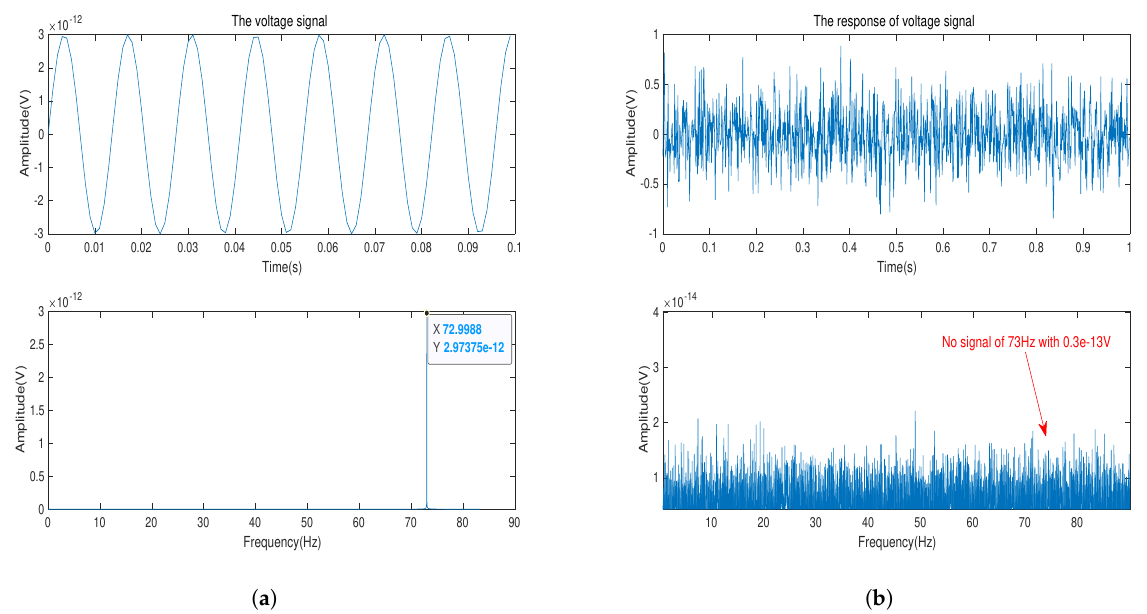
Figure 8. ( a ) The input-voltage signal with amplitude of 0.3 × 10 − 11 V and its frequency spectrum. ( b ) The acquisition voltage signal in time-domain and its frequency spectrum after time gain of 168